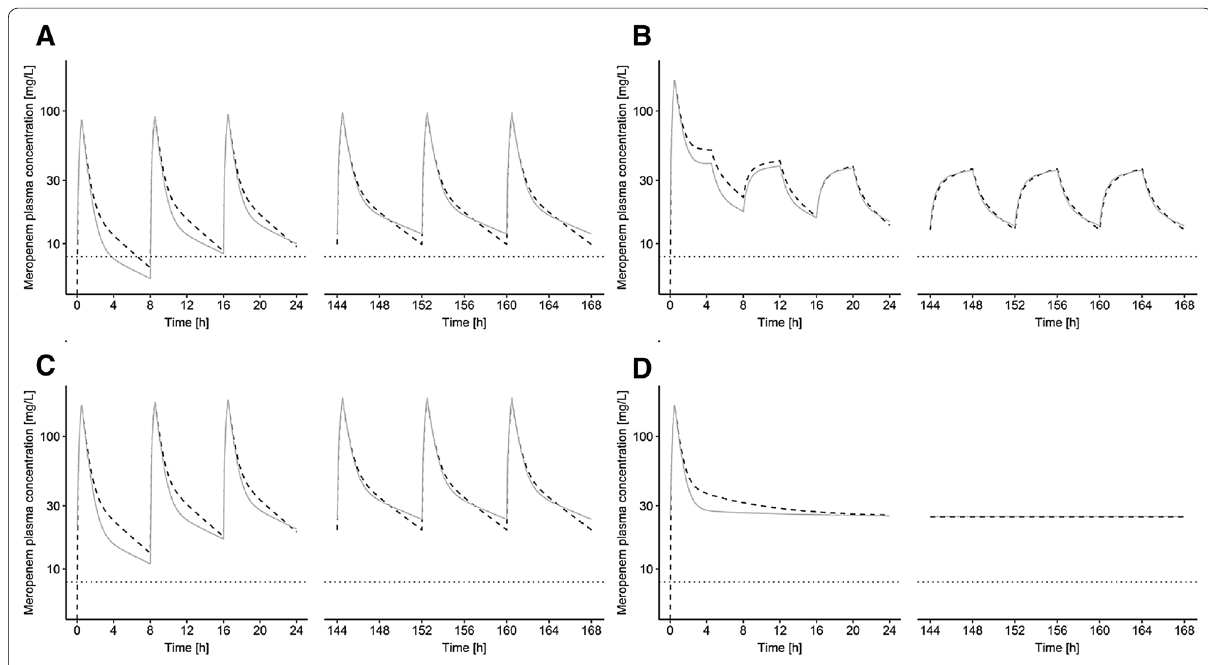
Fig. 3 Deterministic simulations of meropenem. a 1 g quid 8 h (30 min); b 2 g loading dose (30 min) followed by 1 g prolonged infusion (over 4 h) quid 8 h; c 2 g quid 8 h (30 min); d 2 g loading dose (30 min) followed by continuous infusion of 3 g/day. Solid lines: typical patient without liver failure; dashed line: typical acute‑on‑chronic liver failure patient; dotted horizontal line depict typical target concentrations as 4x European Committee on Antimicrobial Susceptibility Testing epidemiological cut‑off values (ECOFF) for Pseudomonas spp. (4